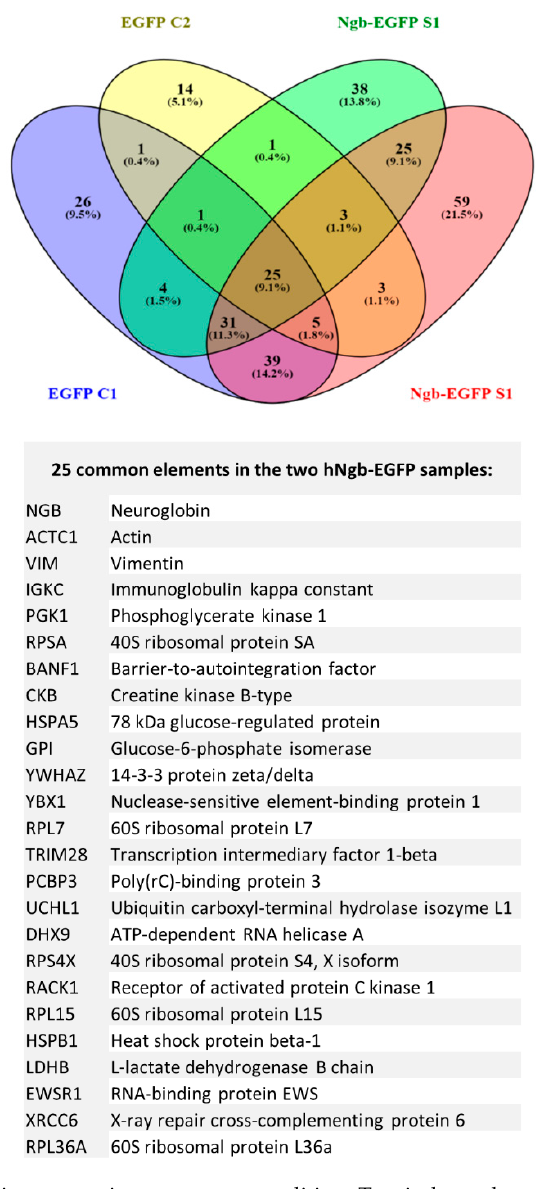
Figure 3. hNgb protein interactors in a non-stress condition. Two independent co-immunoprecipitation (Co-IP) experiments were performed, followed by an LC-MS / MS analysis. We detected 122 proteins in the hNgb-EGFP samples, of which 25 could be validated in both analyses. Proteins identified in the EGFP control samples 1 and / or 2 were considered to be false positives and were not considered for subsequent analyses. The Venn diagram was created by using the online tool Venny 2.1 (http://bioinfogp.cnb.csic.es/tools/venny/).